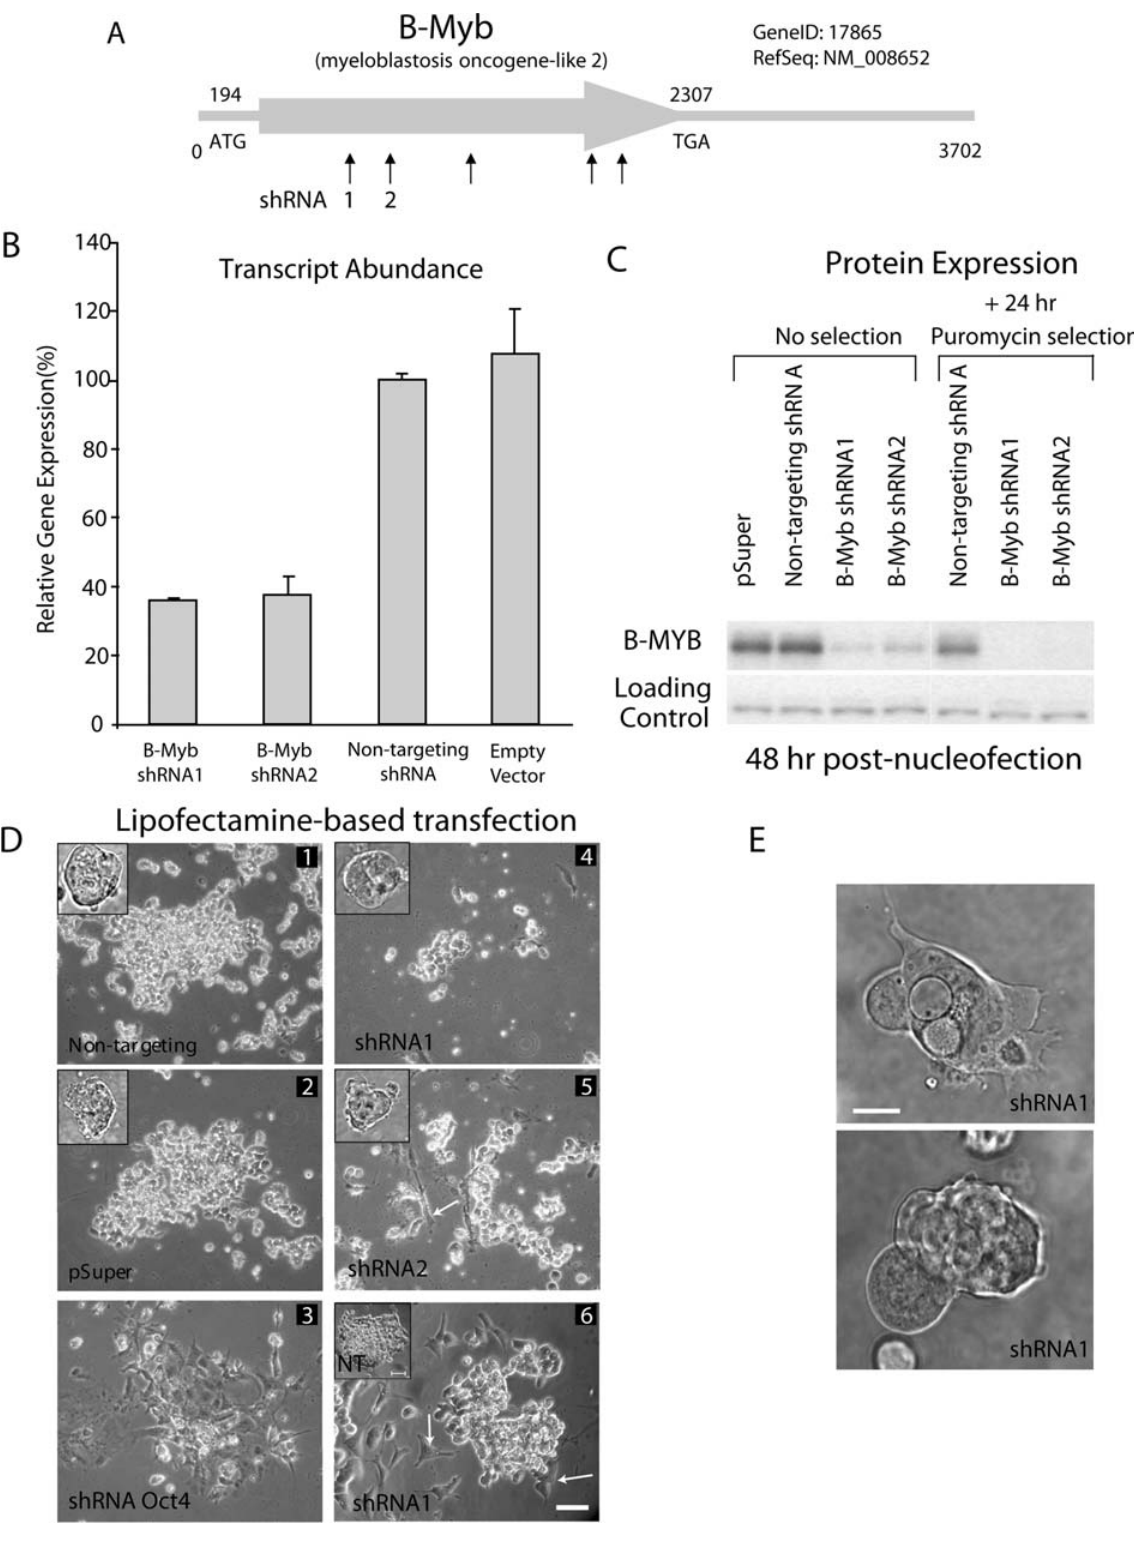
Figure 2. shRNAs specifically knockdown B-Myb in ES cells . A) Line drawing of B-Myb and location of silencing shRNAs tested in this study. B) Endogenous B-Myb mRNAs are effectively reduced following cell transfections with shRNAs against B-Myb (shRNA1, shRNA2), but no reduction in B- Myb could be demonstrated with the negative controls [non-targeting (NT) shRNAs or empty vector (pSuper.puro)]. C) By western, B-MYB proteins were reduced in ES cells by , 50–70% following knockdown with shRNA1 or shRNA2, but when selected with puromycin, reductions in B-MYB of . 90% were routinely seen. Loading controls indicate that the shRNAs were specific for B-Myb. D) Representative cell morphologies of R1 and D3 mES cells after transfection. The insets in panels 1, 2, 4 and 5 correspond to cell morphologies of R1 cells 24 hours after nucleofection and prior to